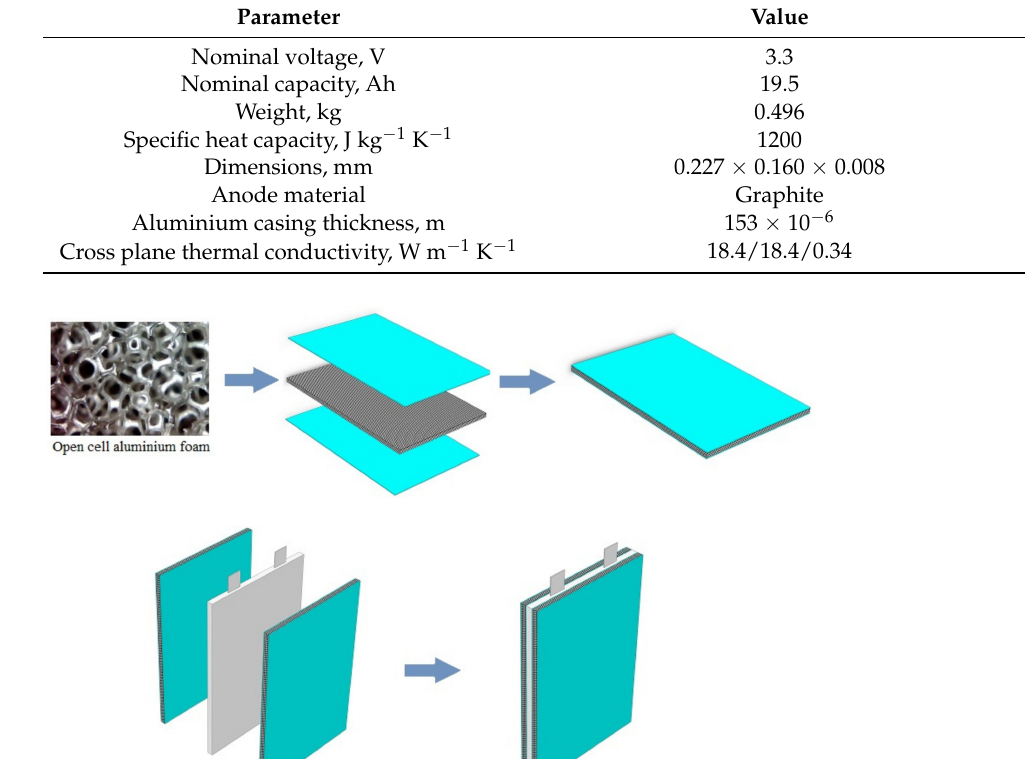
Table 1. Parameters of the 20 Ah LiFePO4 pouch battery [35]. Reproduced with permission from [Applied energy]; published by [Elsevier], (2017).